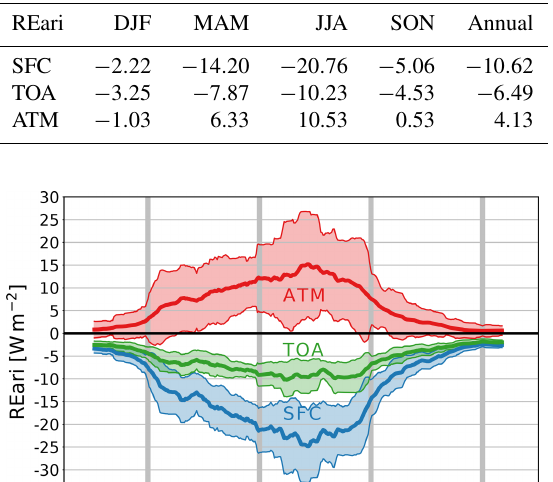
centration, surface REari shows lower values in the southern